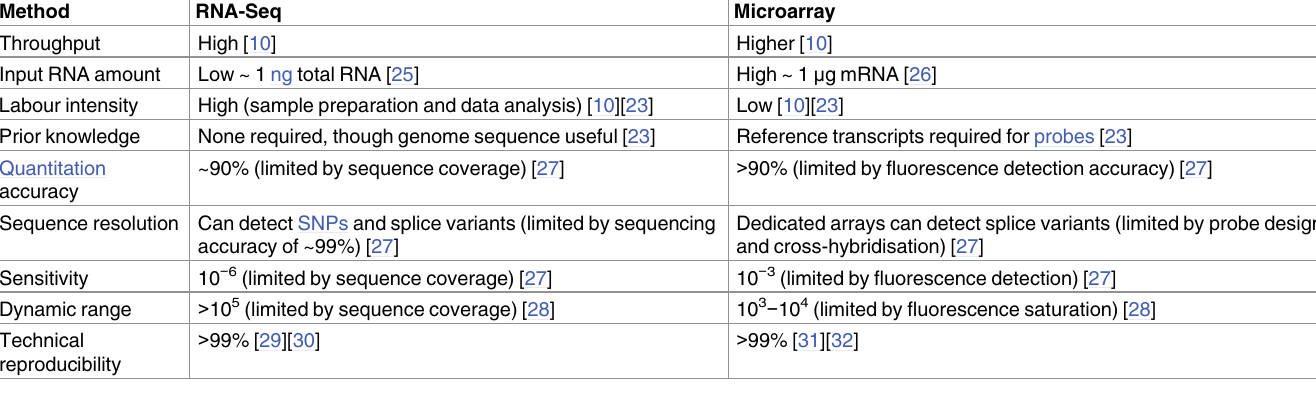
Table 1. Comparison of contemporary methods [23] [24]